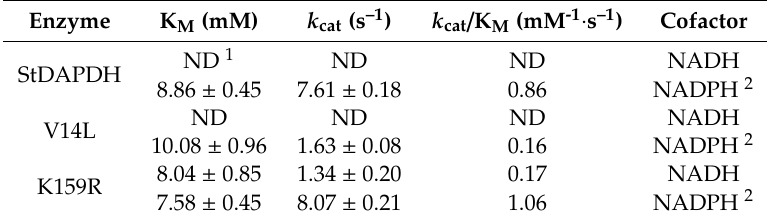
Table 1. Kinetic parameters of wild-type and mutant StDAPDH with pyruvic acid as the substrate Enzyme K M (mM) k cat (s –1 ) k cat / K M (mM -1 · s –1 )